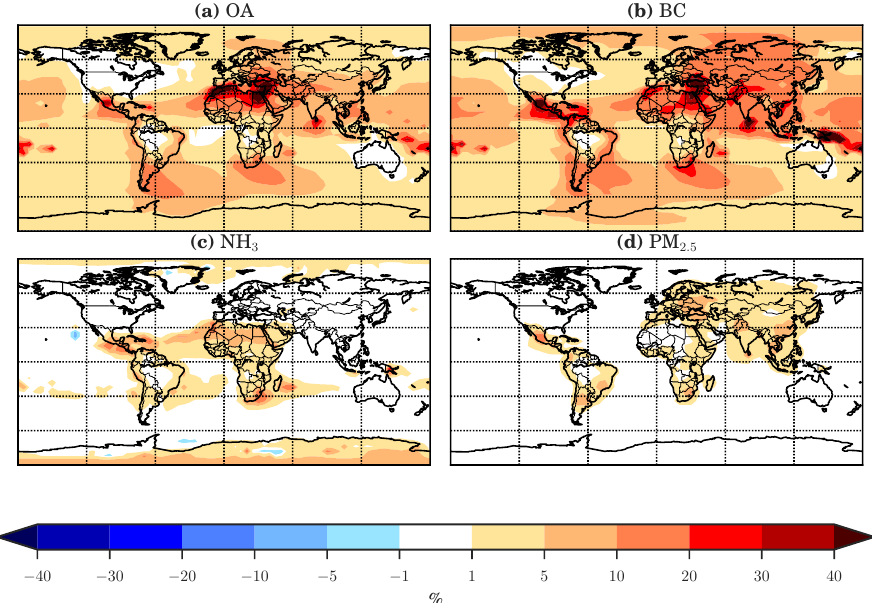
Figure 3. Percent changes in annually averaged boundary-layer (a) OA, (b) BC, (c) NH 3 , and (d) PM 2 . 5 mass due to domestic-waste combustion (BASE-WASTE_OFF). Table 3. Global-mean all-sky direct radiative effect and cloud-albedo aerosol indirect effect relative to the WASTE_OFF simulation for all sensitivity simulations and mixing-state assumptions. Simulation Direct radiative effect (mWm − 2 ) AIE (mWm − 2 ) Core–shell, BrC Ext ∗ 1.5, BrC Homogenous